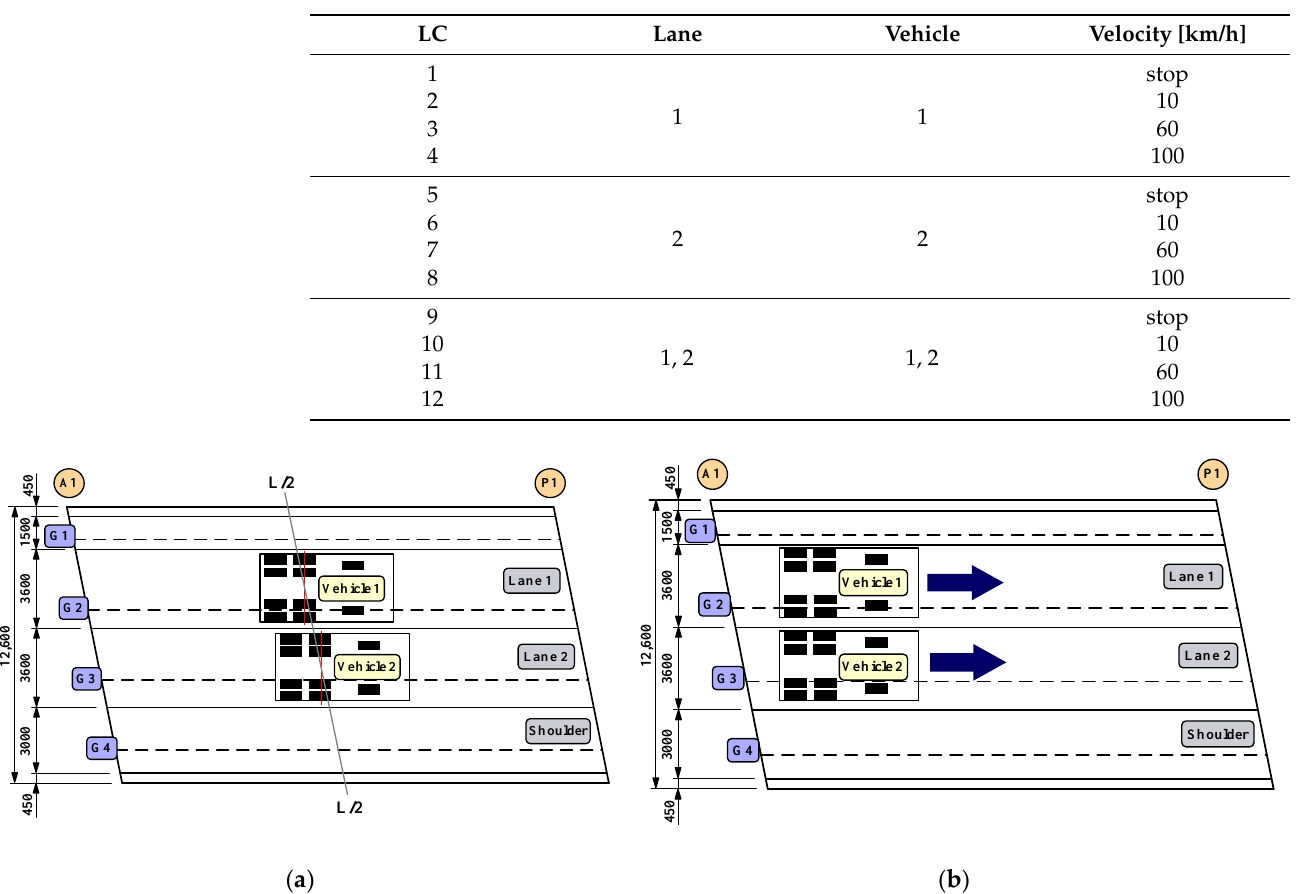
Figure 6. Vehicle loading positions in the vehicle loading test: ( a ) Static loading test; ( b ) Dynamic loading test.